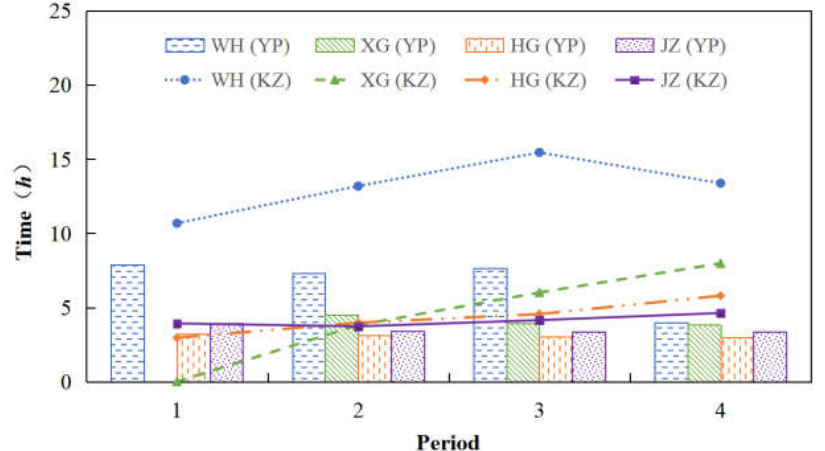
Figure 7. Time required to obtain emergency materials at each affected site in each time period based on the balance-criterion.